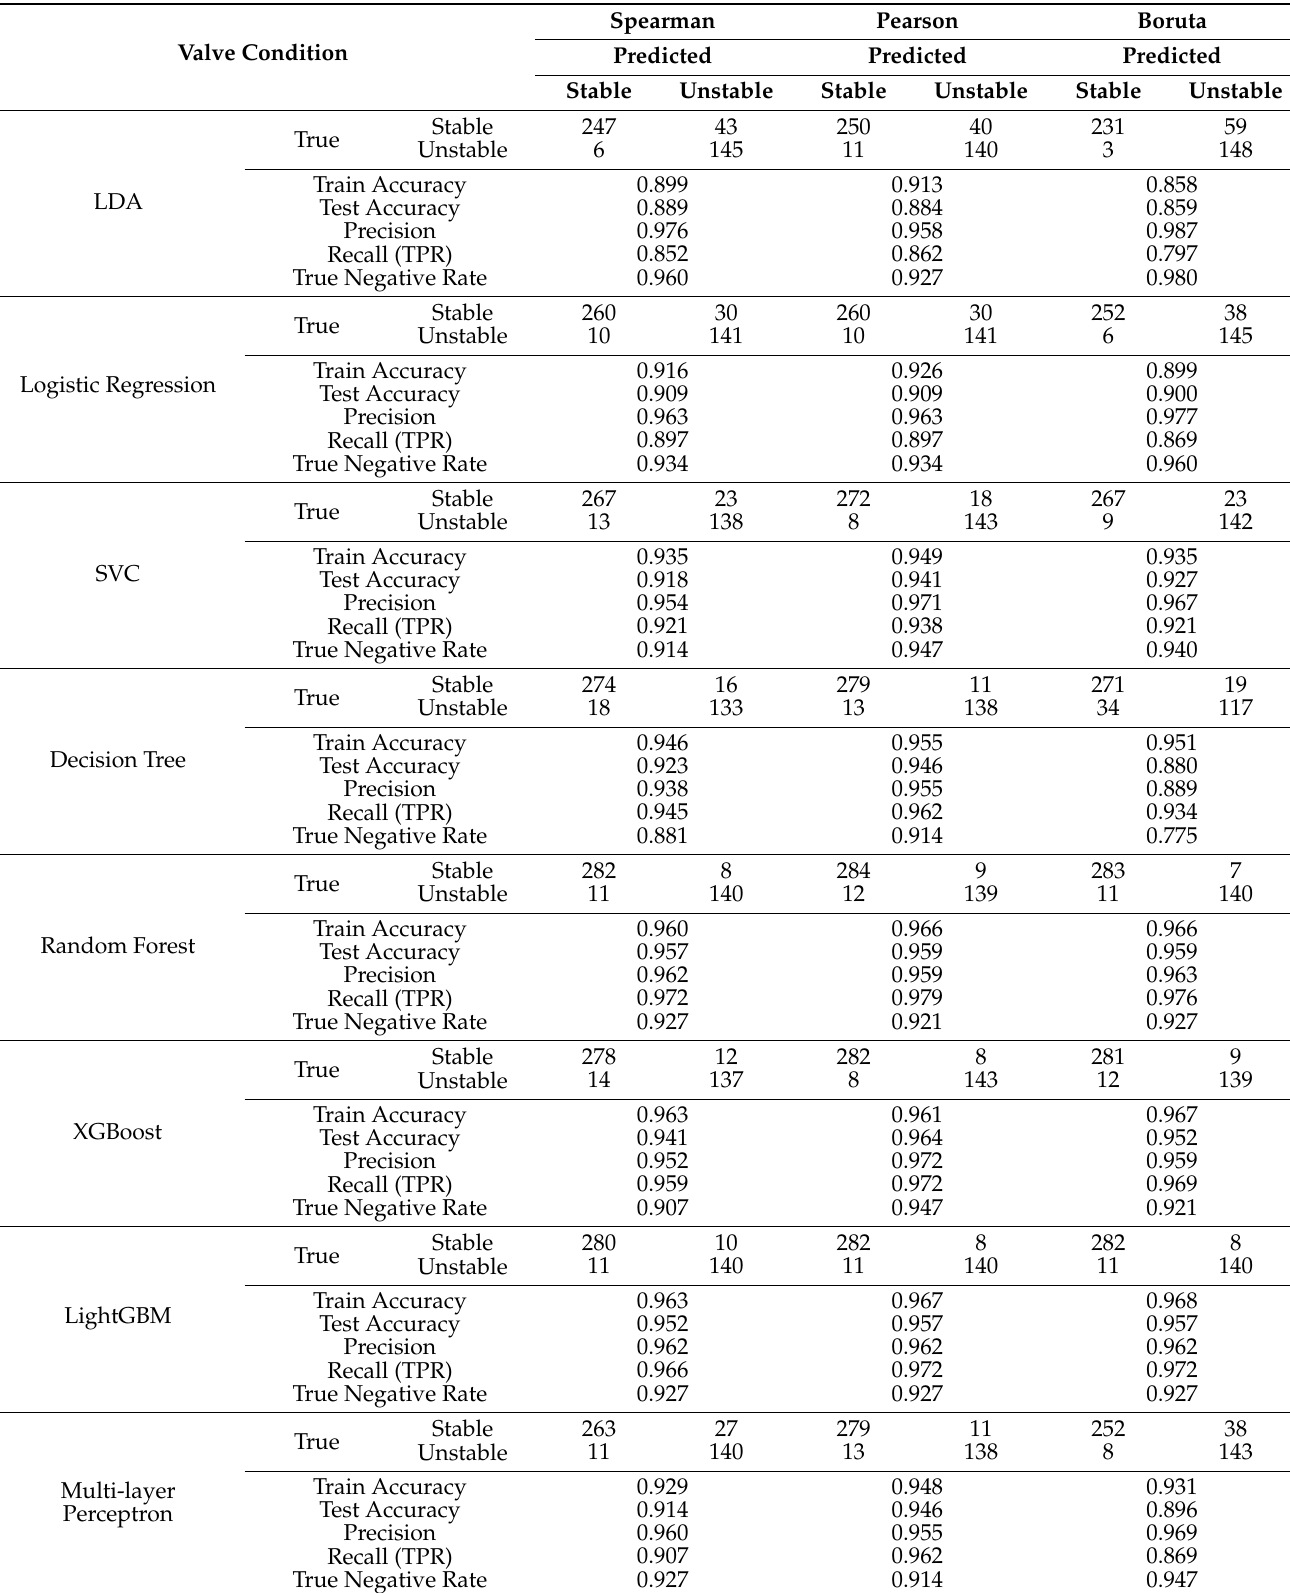
Table 8. Classification evaluation metrics for valve